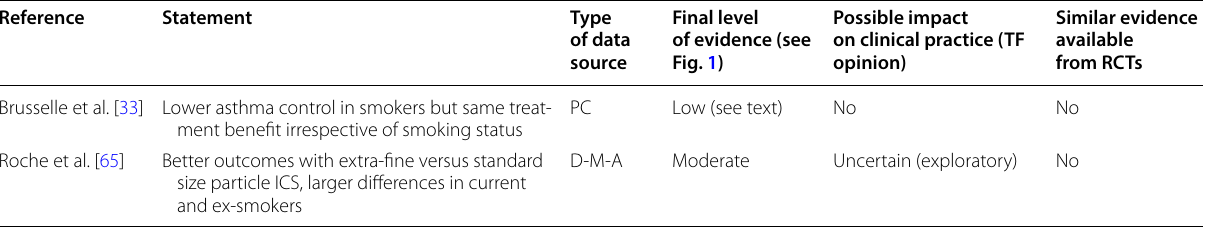
Table 5 Summary table of literature analysis, PICOT question 3: influence of smoking on asthma outcomes in patients